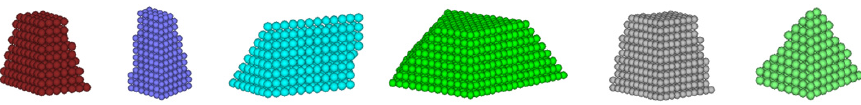
Figure 1. Coarse aggregates generated with the algorithm.